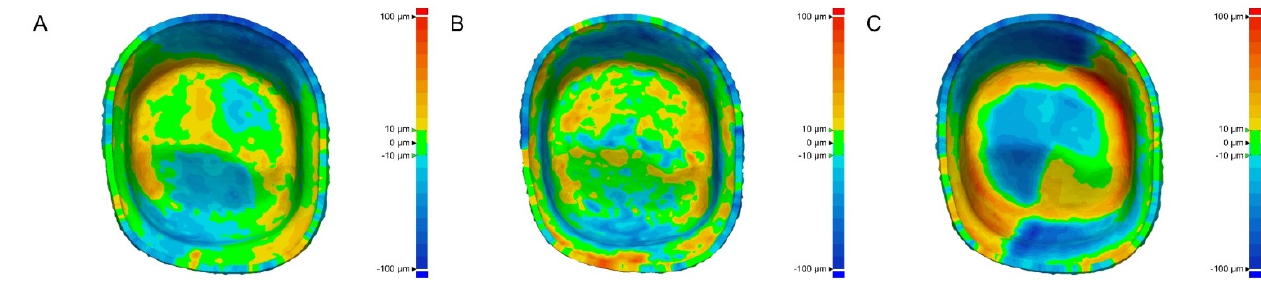
Figure 2. Schematic of color difference map of intaglio surface trueness of interim crowns. ( A ) SLA. ( B ) DLP. ( C ) Milling.